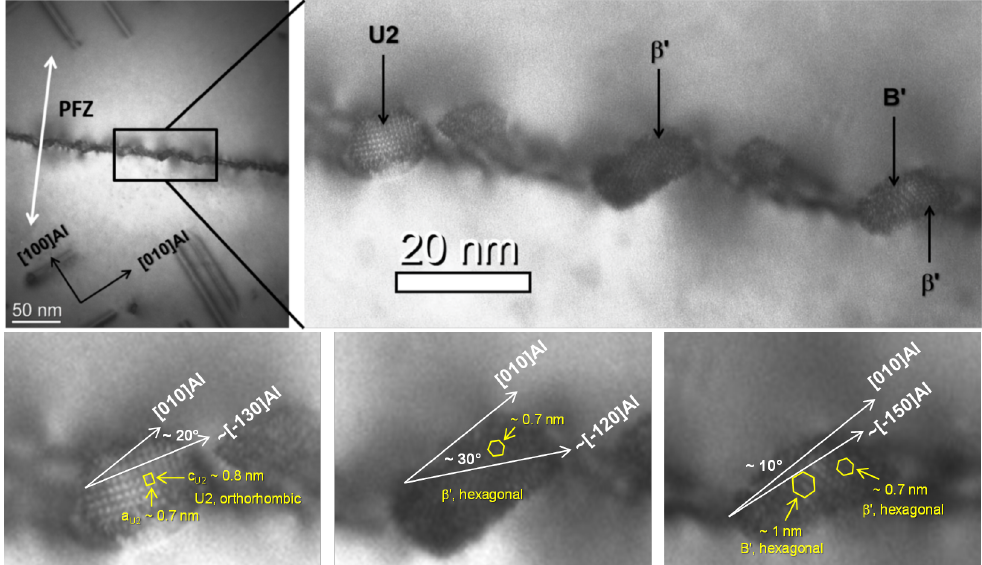
Figure 1. Bright-field TEM image of grain boundary precipitates on a low angle grain boundary in a 6060 aluminium alloy. The unit cell periodicities and angles for the different phases are shown below.